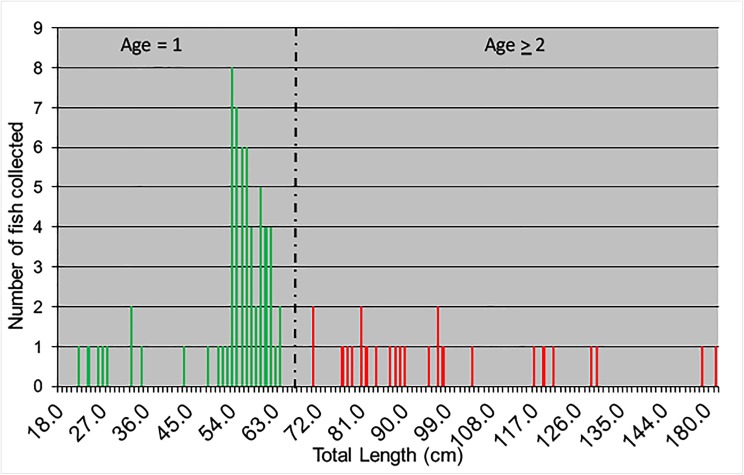
Length frequency histogram of the 2014 Connecticut River Atlantic Sturgeon collection.Green bars represent individual juvenile specimens from which 45 individuals were analyzed genetically. Red bars represent specimens that were not genetically analyzed because of their larger size.